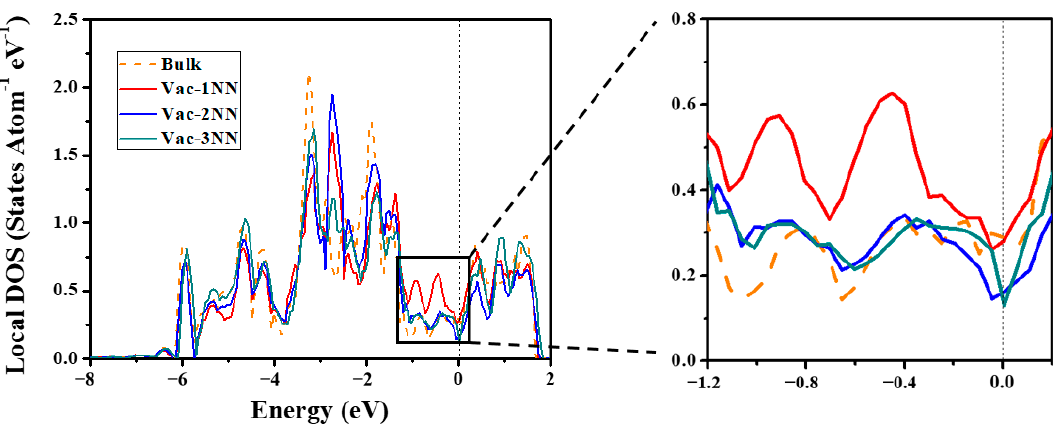
Figure 2. The local density of states (LDOSs) projected on the 5 d orbitals of a bulk W atom (orange dashed line) and 1NN (red solid line), 2NN (blue solid line), and 3NN (green solid line) W atom of the monovacancy in strain-free case. The Fermi level is denoted by the black dashed line.